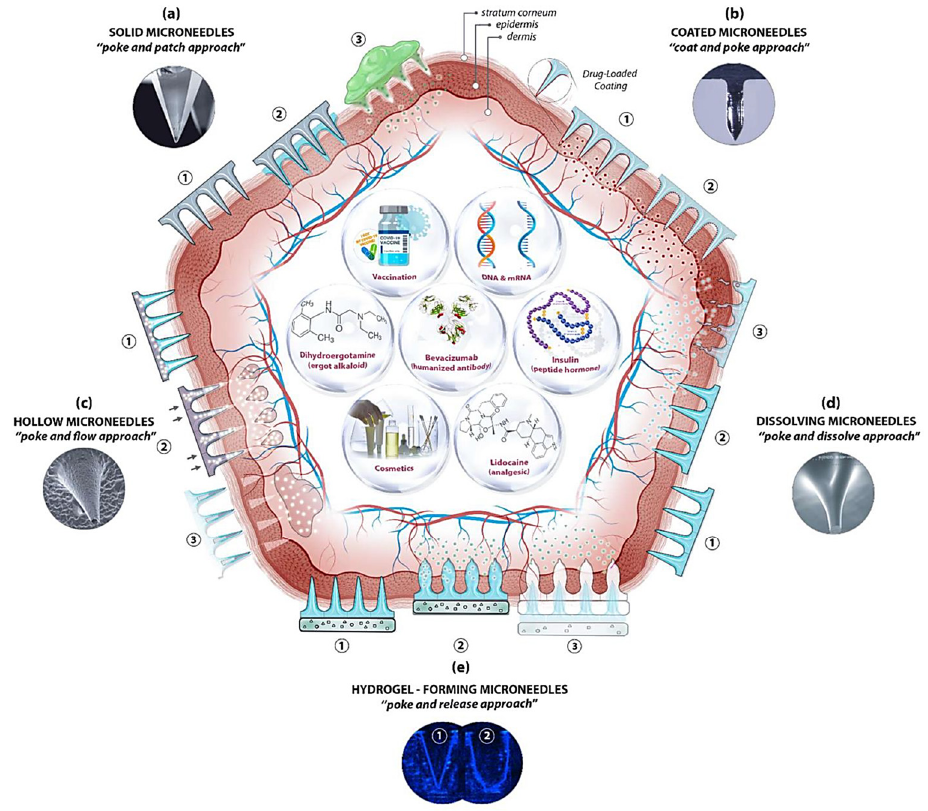
Figure 3. Drug delivery via different types of MNs: ( a ) solid MNs, ( b ) coated MNs, ( c ) hollow MNs, ( d ) dissolving MNs, and ( e ) hydrogel-forming MNs. The step-by-step process of each delivery approach is numbered from 1 to 3 [56].